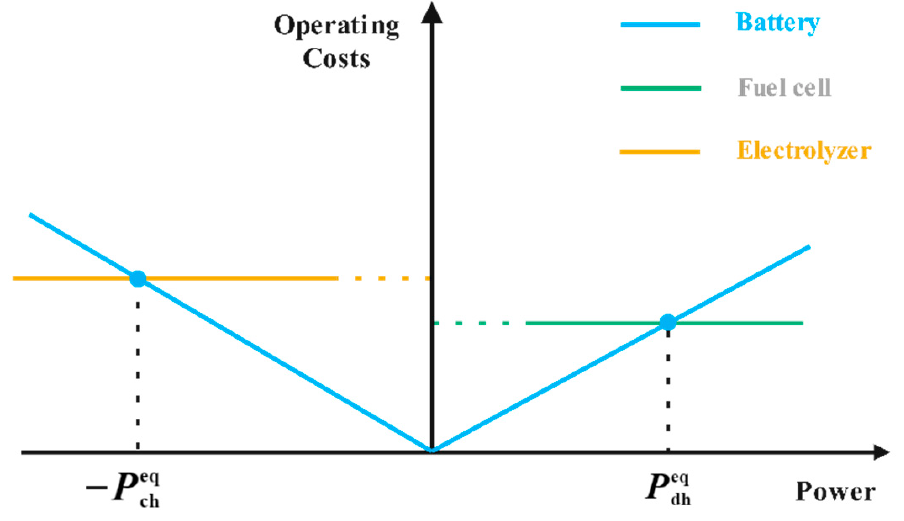
Figure 2. Relationship between cost and power demand. In the first quadrant, the abscissa corresponding to the intersection of the battery operation (discharge) cost curve and the hydrogen fuel cell operation cost curve P eq is the dh equal discharge cost operation power of both. If the battery and hydrogen fuel cell have enough energy storage in the next period of time, when the net power P net ( t ) is greater than the equal discharge cost operating power P eq , the hydrogen fuel cell will give priority dh to output (block G, H, I), because the cost of using the hydrogen fuel cell for power supply is lower than that of the battery. If the required net power is greater than the maximum operating power P max of the hydrogen fuel cell, the insufficient power is supplemented FC by the battery. In contrast, when P net ≤ P eq , the battery gives priority to output (block dh F). Similarly, in the second quadrant, the abscissa corresponding to the intersection of the battery operation (charging) cost curve and the alkaline electrolytic cell operation cost curve − P eq is the equal charge cost operation power of both. If the battery and the hydrogen ch storage tank have sufficient capacity in the next period of time, when the absolute value of net power | P net | is greater than the absolute value of equal charge cost operating power (cid:12) (cid:12) eq (cid:12) (cid:12) (cid:12) P (cid:12) , the alkaline electrolytic cell will give priority to output (block O, P, Q), because the ch cost of absorbing the excess power by the alkaline electrolytic cell is lower than that of the battery. If the absolute value of required net power is greater than the maximum operating power P max of the alkaline electrolytic cell, the excess power is absorbed by the battery. In EL (cid:12) (cid:12) eq (cid:12) (cid:12) contrast, when | P net | ≤ (cid:12) P (cid:12) , the battery gives priority to charge (block R). The detailed ch scheduling process is shown in Figure